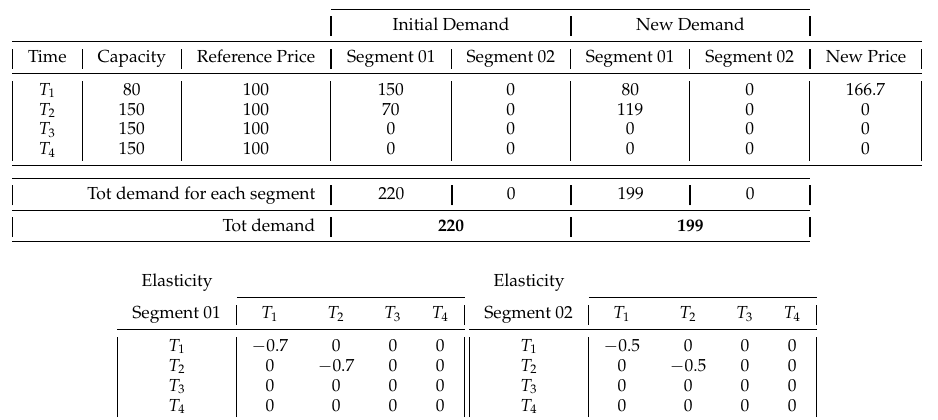
Table 2. Case Study 6.01—basic sub-case, data, and